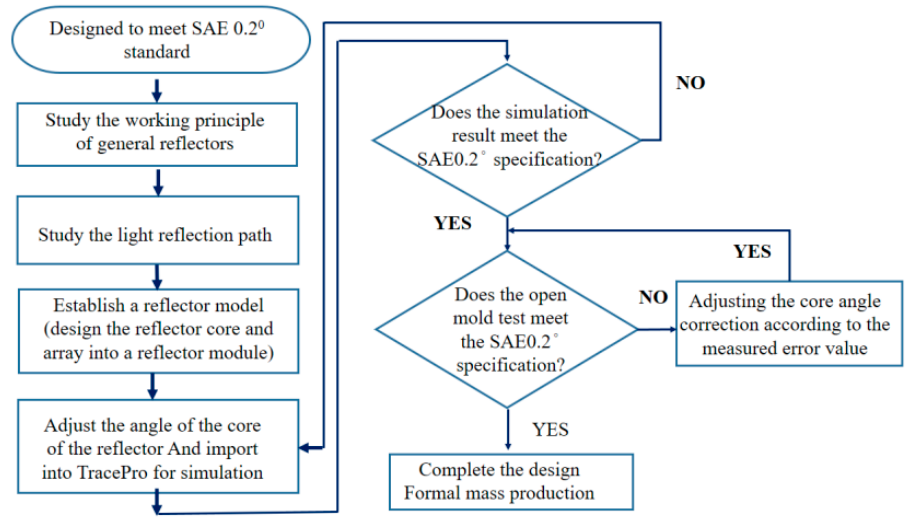
Figure 20. Reflector design flowchart.